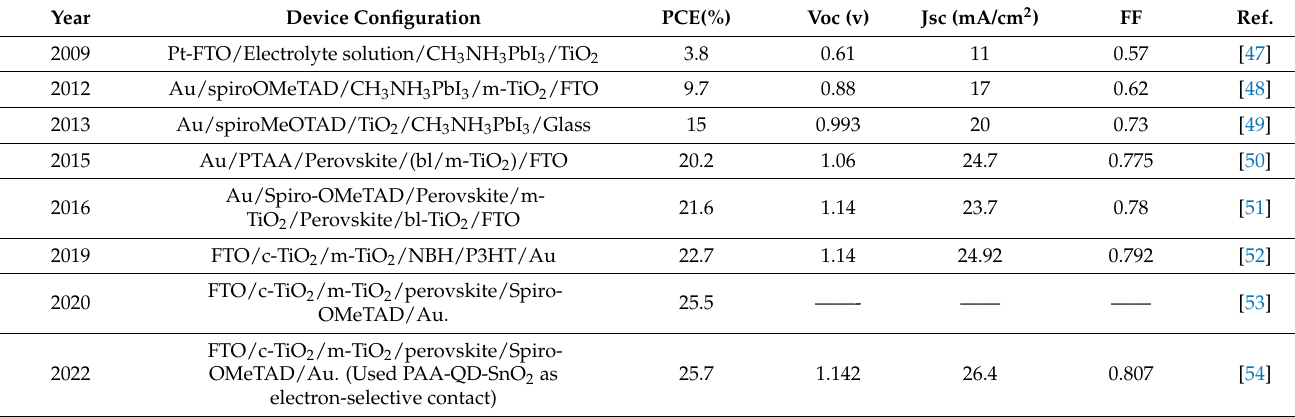
Table 1. Perovskite solar cell developments over the